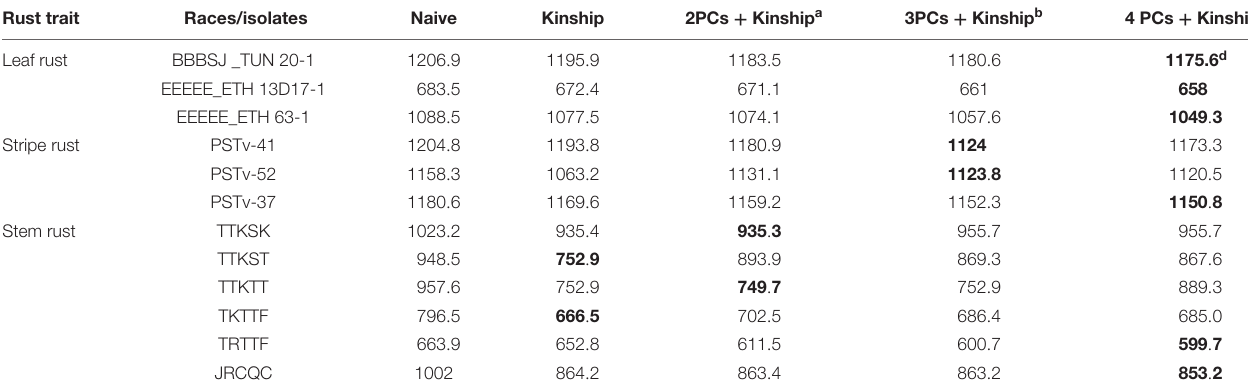
3PCs + Kinship b 4 PCs + Kinship